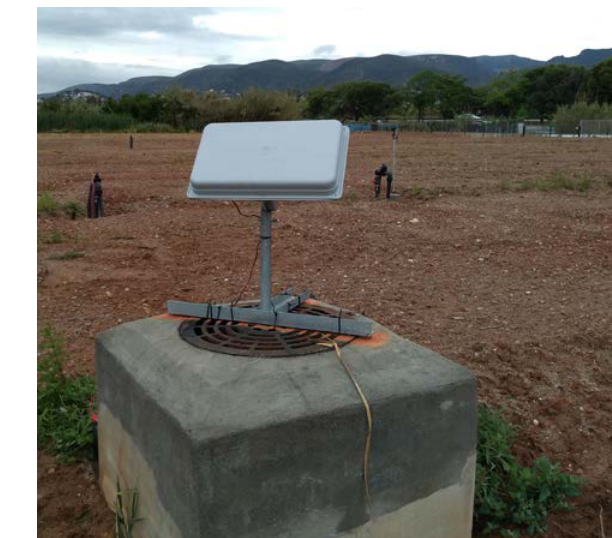
Figure 4. AR prototype installed in the campus of